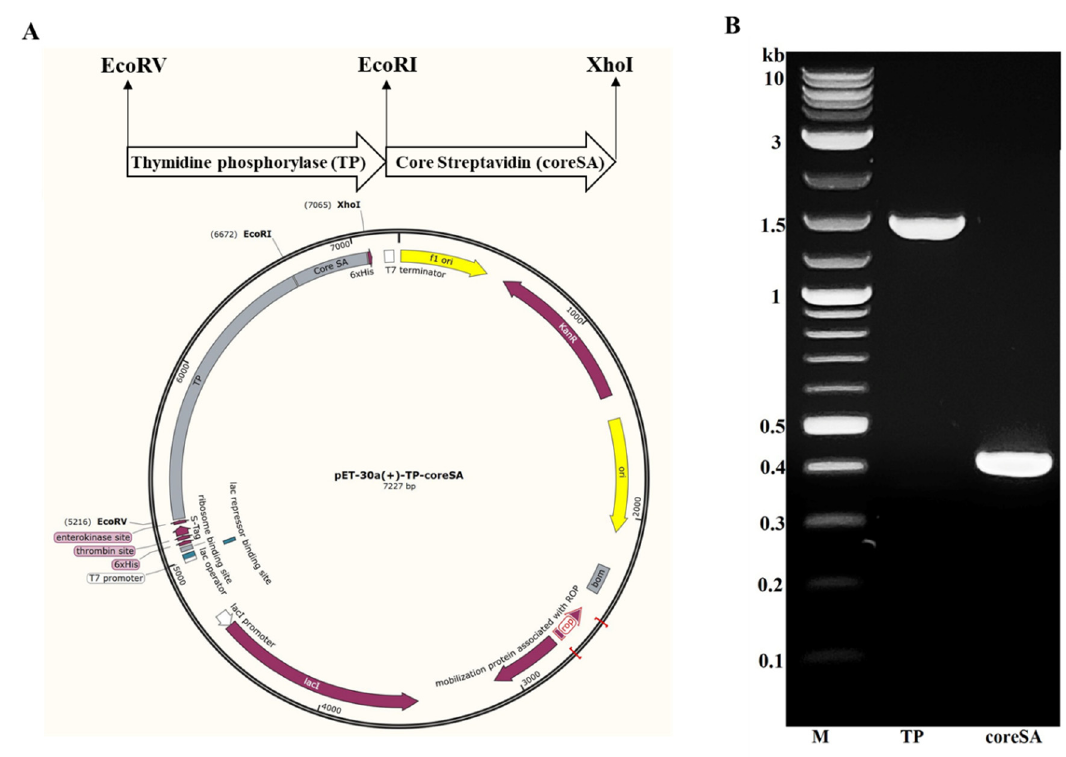
Figure 1. Construction of pET-30a(+)-TP-coreSA. ( A ) vector map showing the cloning site of TP and coreSA in between EcoRV (forward primer)/EcoRI (reverse primer) and EcoRI (forward primer)/XhoI (reverse primer), respectively. The direction of arrows shows the 5 ′ to 3 ′ end of each insert. ( B ) DNA agarose gel confirmation of PCR products (TP~1.4 kb, coreSA~0.4 kb) cloned from pET-30a(+)-TP-coreSA.